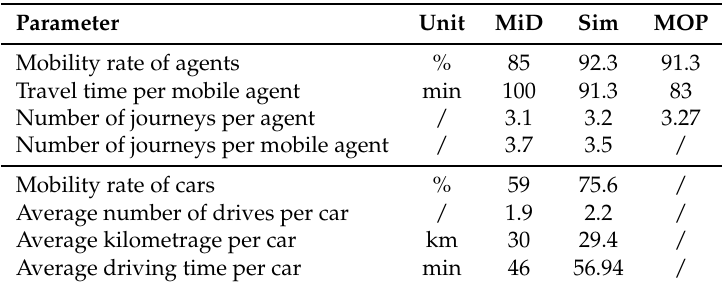
Table 9. Average mobility parameters per